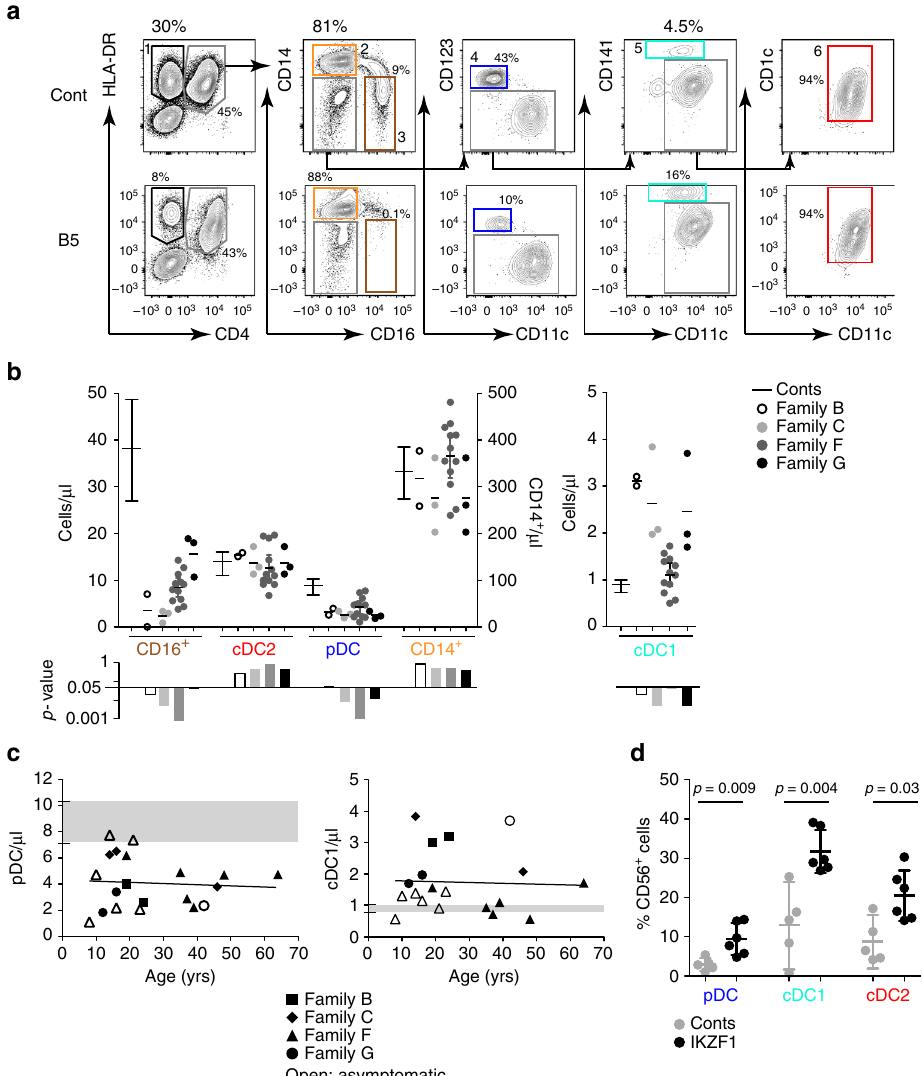
Fig. 2 Reduced pDC and non-classical monocytes but expanded cDC1 in the IKZF1 haploinsuf fi ciency cohort. a Flow cytometric quanti fi cation of PB monocyte and dendritic cell (DC) subsets showing HLA-DR + CD4 − B cells, CD14 + classical (orange) and CD16 + non-classical monocytes (brown), CD123 + plasmacytoid DCs (pDC) (blue), CD141 + conventional DC1 (cDC1) (turquoise) and CD1c + cDC2 (red) in healthy donor (cont, (control)) and representative individual with IKZF1 mutation. b Absolute counts of monocytes and DCs in 20 individuals from 4 affected families compared to n = 32 healthy donors. Bars show mean ± 95% con fi dence interval (CI). Histograms show subset-speci fi c p -values for each family compared to healthy donors by two-tailed Mann – Whitney U -test with signi fi cance set at p < 0.05. c Absolute pDC or cDC1 counts plotted against the age of the individual. Grey zones represent the normal range of healthy controls ( n = 32), black lines represent linear regression analysis with p = 0.77 and p = 0.86, respectively. d Proportion of cells expressing CD56 in healthy donors ( n = 5) and individuals carrying IKZF1 mutation ( n = 6). Bars represent mean ± 95% CI. The p -values derived from